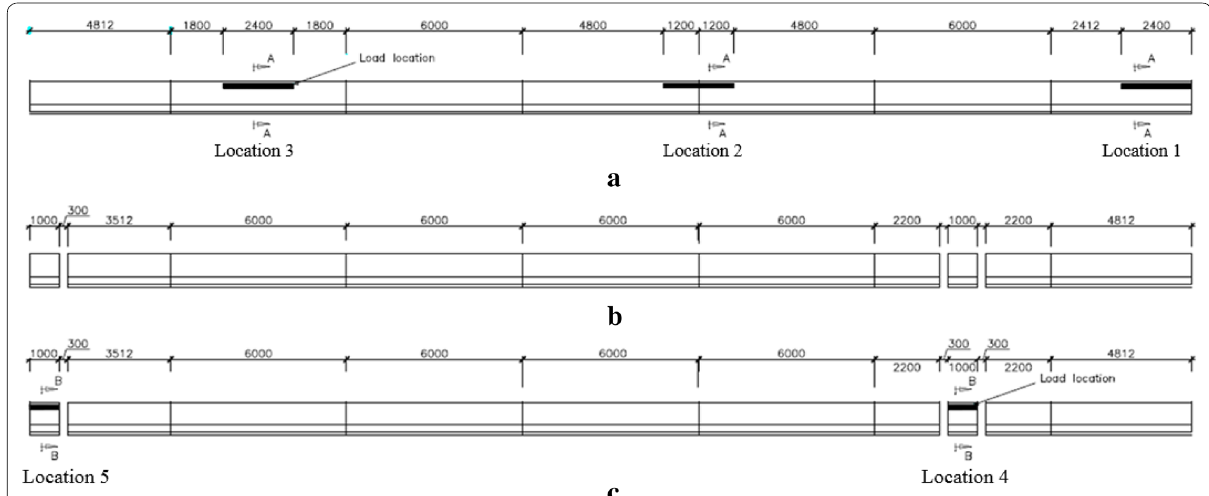
Fig. 4 Schematics diagrams of the barrier showing control joints and applied load locations. a Phase 1: loading the barrier wall over 2400 mm length at three locations, b phase 2: saw-cut the barrier wall at two locations, c phase 3: loading the barrier wall over 1000 mm length at two